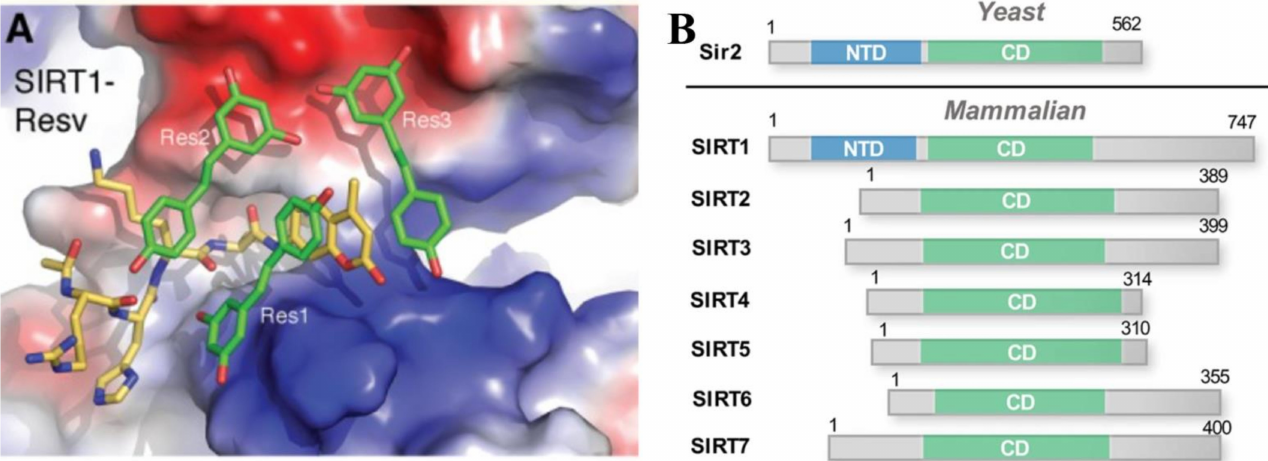
Figure 3. ( A ) A surface representation (with electrostatic potential distribution) of SIRT1 with the bound p53-AMC peptide and RESV. Both the peptides (carbon colored gold) and RESV (carbon colored green) are shown as a stick model. Reused with permission from Cao et al. [179]. ( B ) Comparison of yeast Sir2 amino acid sequence to seven mammalian SIRT1-7. The conserved, catalytic domain (CD) that all sirtuins have in common is colored in green. The N-terminal domains (NTDs) that are unique to yeast Sir2 and mammalian SIRT1 are colored in cyan. Numbers refer to amino acid residues in the proteins. Reused with permission from Hou et al.